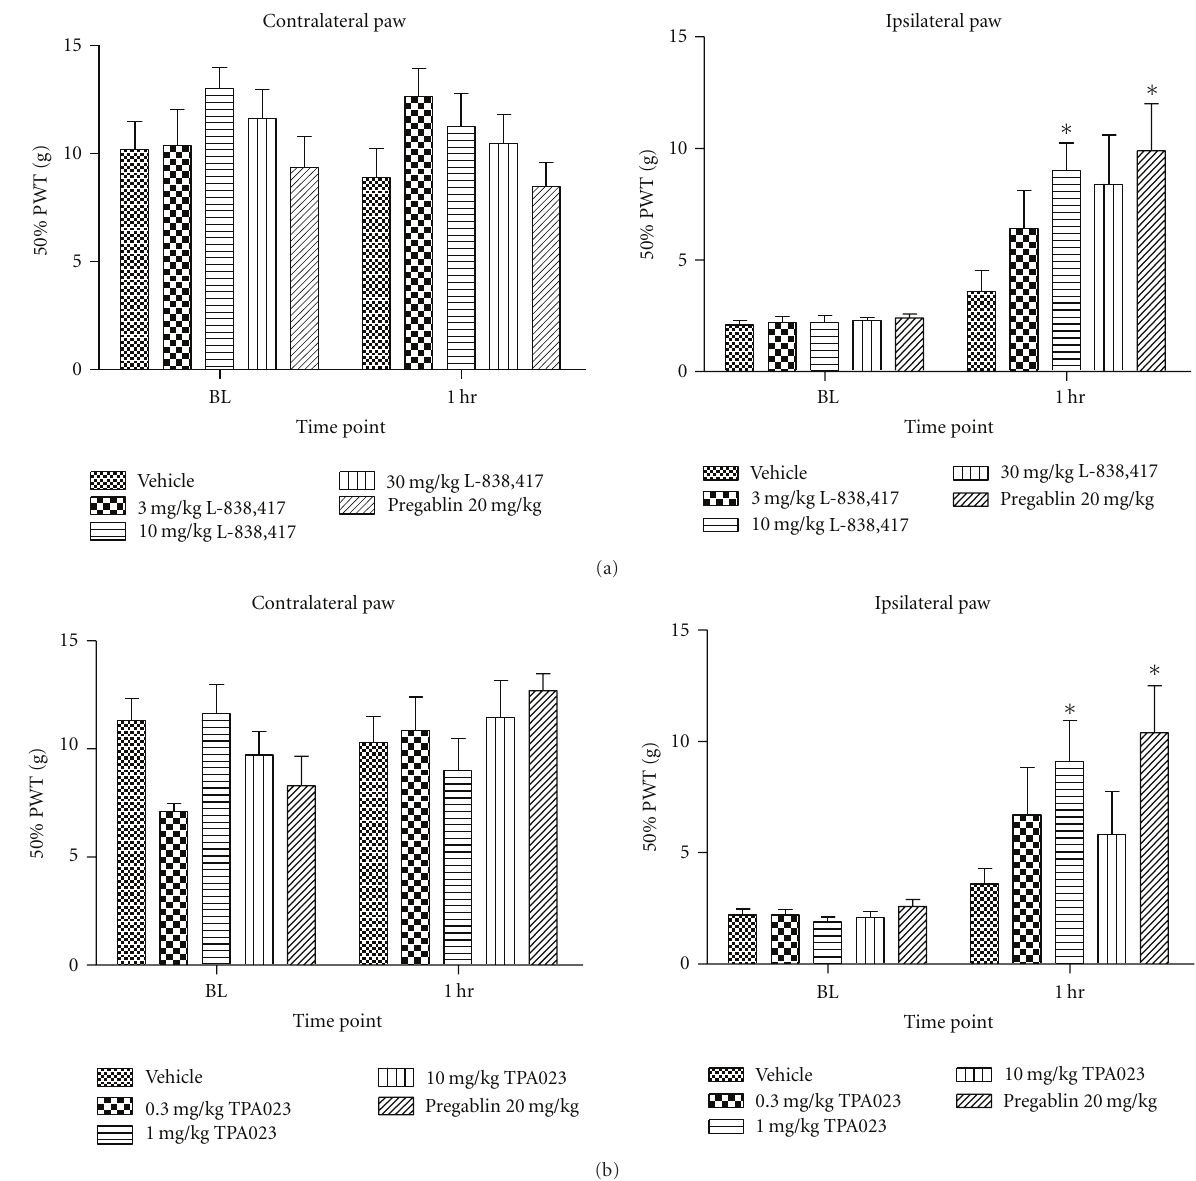
Figure 4: The e ff ects of (a) L-838,417and (b) TPA023 on chronic constriction injury-induced static allodynia in the rat. Data are means ± sem. n = 6. Data are expressed as 50% paw withdrawal threshold (PWT). BL: baseline. ( ∗ = P < 0 . 05, ANOVA compared to vehicle-treated